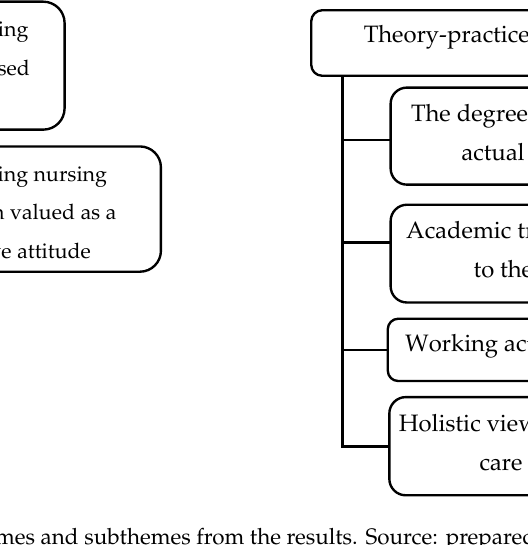
Figure 1. Themes and subthemes from the results. Source: prepared by the author.